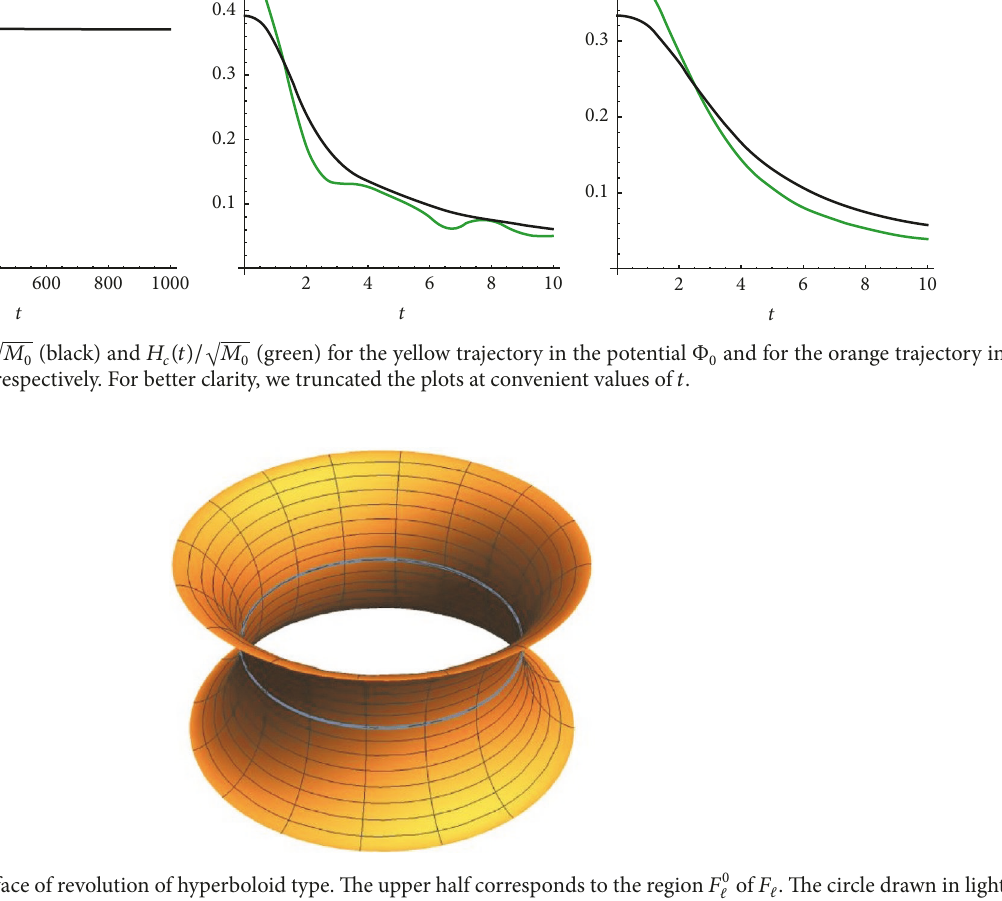
Figure 14: Hyperbolic surface of revolution of hyperboloid type. The upper half corresponds to the region 𝐹 0 ℓ of 𝐹 ℓ . The circle drawn in light blue is the closed geodesic 𝑐 1 of length ℓ